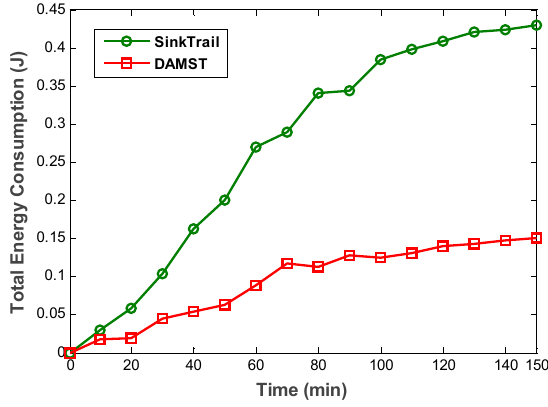
Figure 15. Total energy consumption in DAMST and SinkTrail.